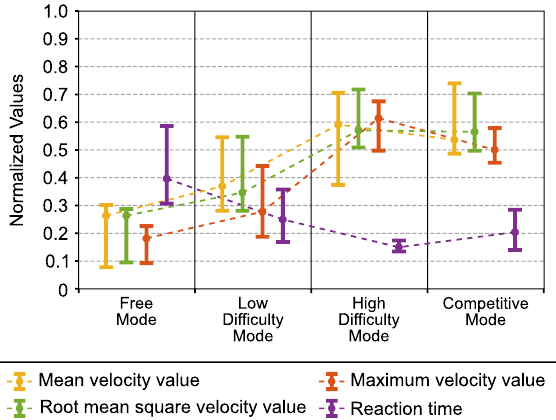
Figure 4. Exercise intensity parameters. All parameters were normalized by the min-max normaliza- tion method and are graphically represented in each game mode by the median value and an error bar representing the first and third